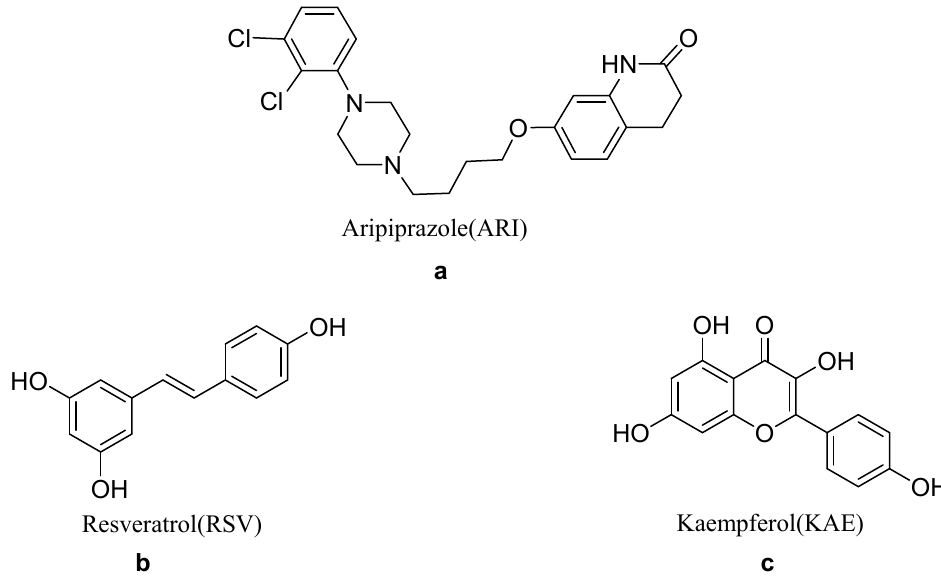
Figure 1. Chemical structures of the aripiprazole ( a ), resveratrol ( b ), and kaempferol ( c ). Resveratrol (RSV, Figure 1b), a naturally occurring polyphenol, has a variety of